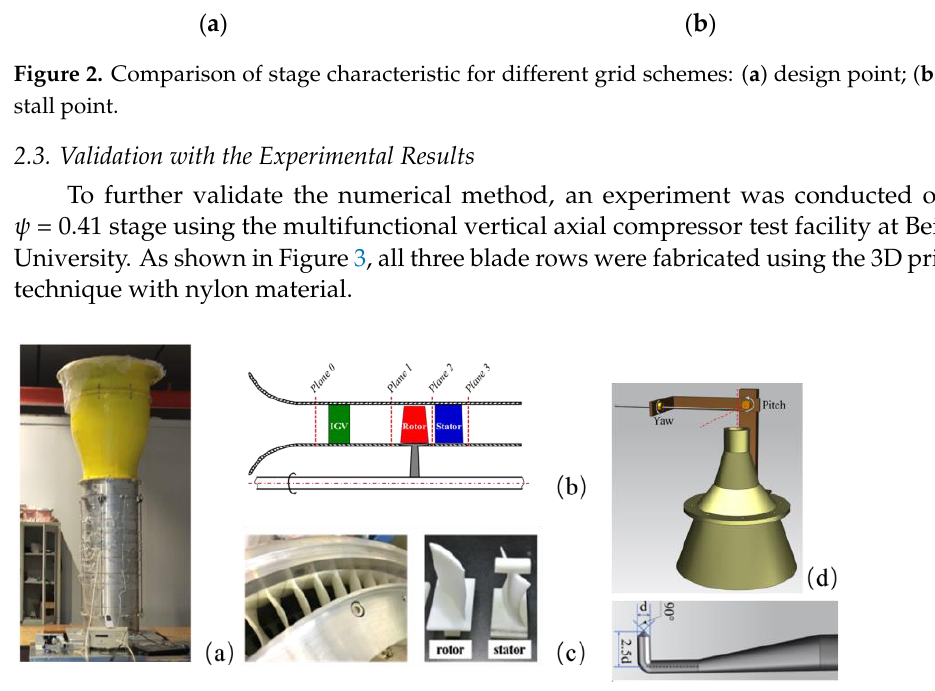
Figure 3. The experimental rig: ( a ) multifunctional vertical axial compressor test facility; ( b ) measurement planes; ( c ) 3D-printed blade; ( d ) the L-shaped five-hole probe.